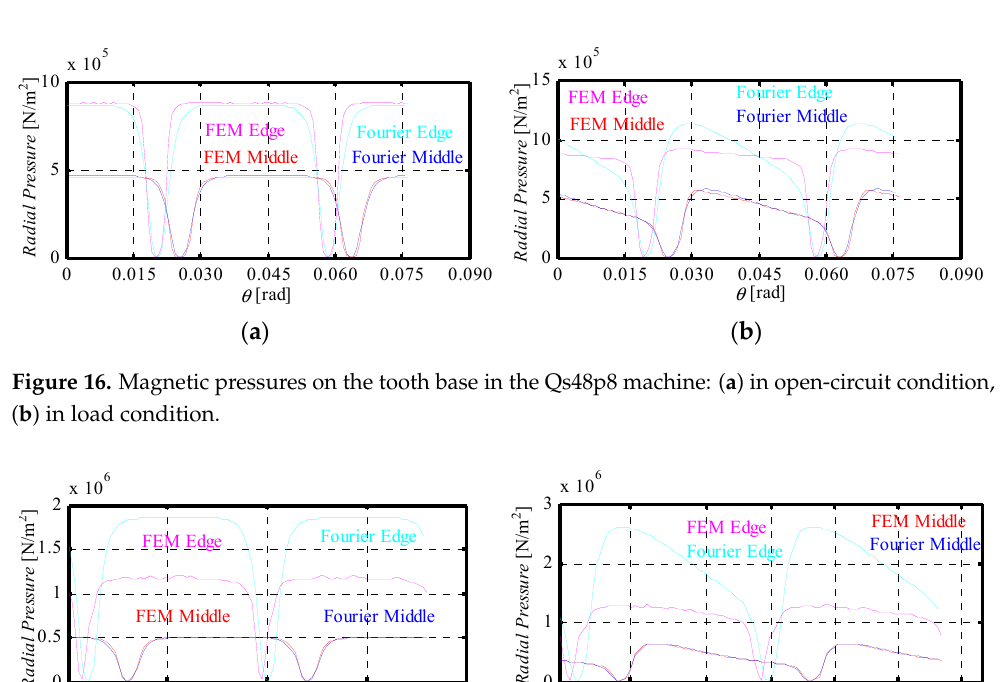
Figure 18. Flux density on the tooth base in open-circuit operation: ( a ) Qs48p8, ( b ) Qs36p15. Figure 17. Magnetic pressures on the tooth base in the Qs36p15 machine: ( a ) in open-circuit condi- tion, ( b ) in load condition.